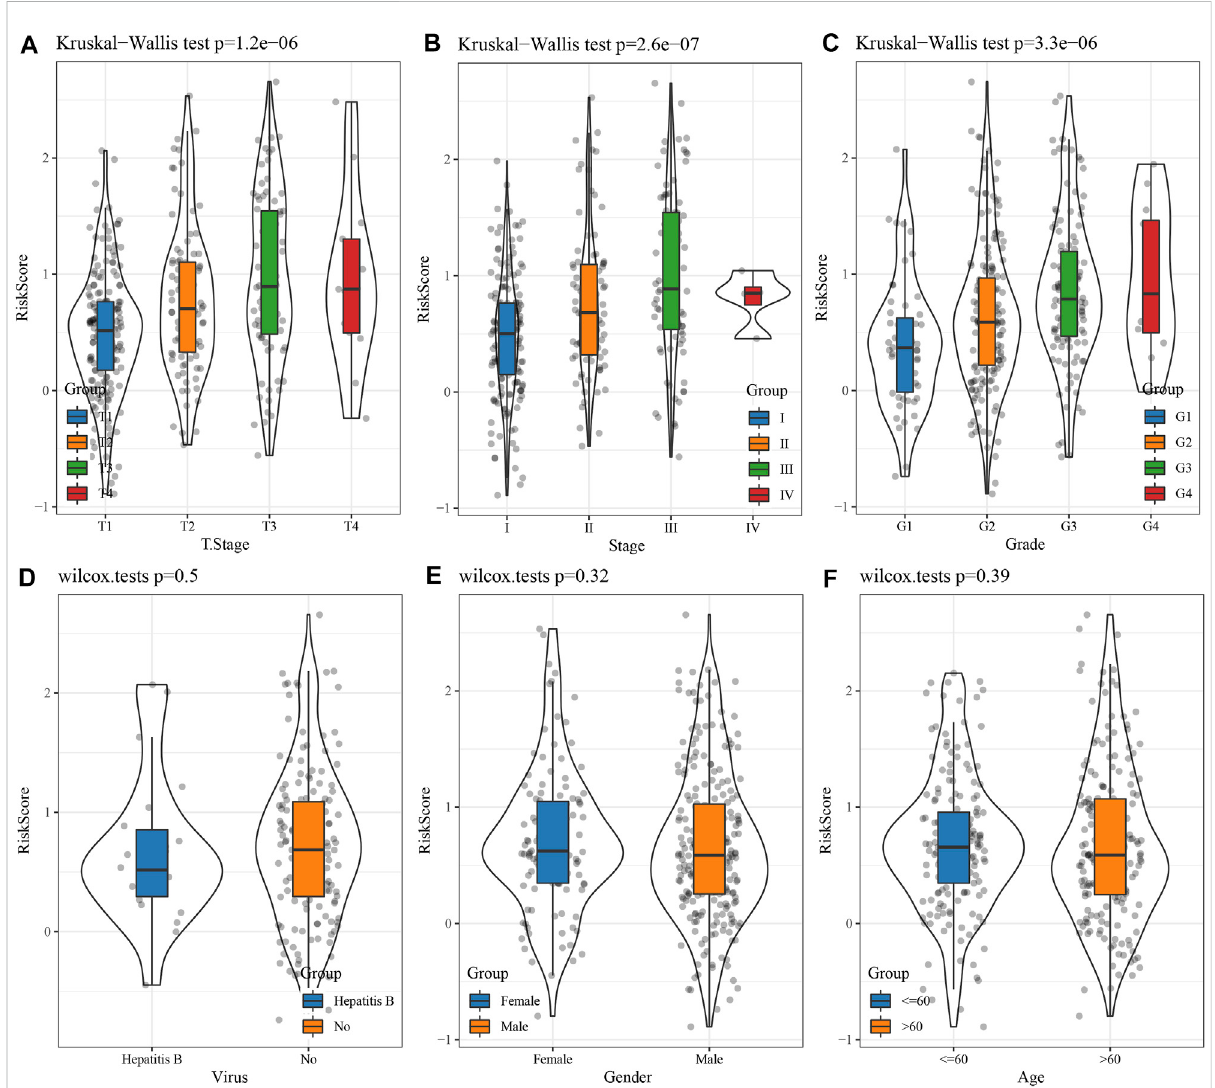
FIGURE 5 Differences in RSs among different clinicopathological groups in the TCGA cohort. (A) T Stage; (B) Stage; (C) Grade; (D) Virus; (E) Gender; (F) Age. (ns, p > 0.05; * * *, p < 0.001; * *, p < 0.01; *, p <